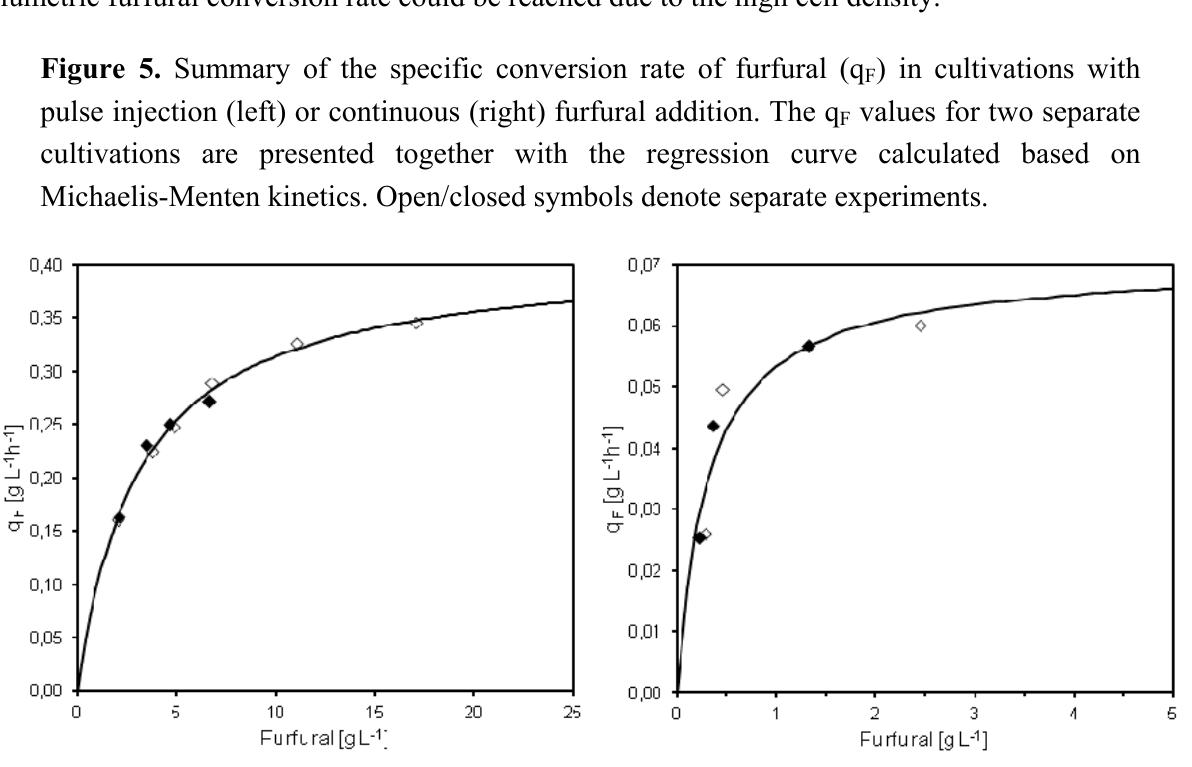
) in cultivations with F values for two separate F